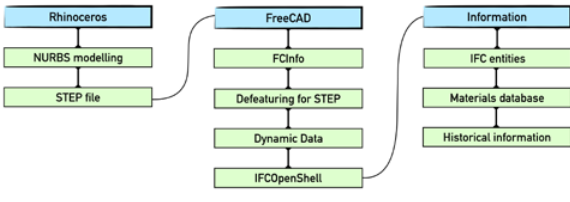
Figure 8. Schematic classification of Grades of Generation (original schema in Banfi F., 2017)